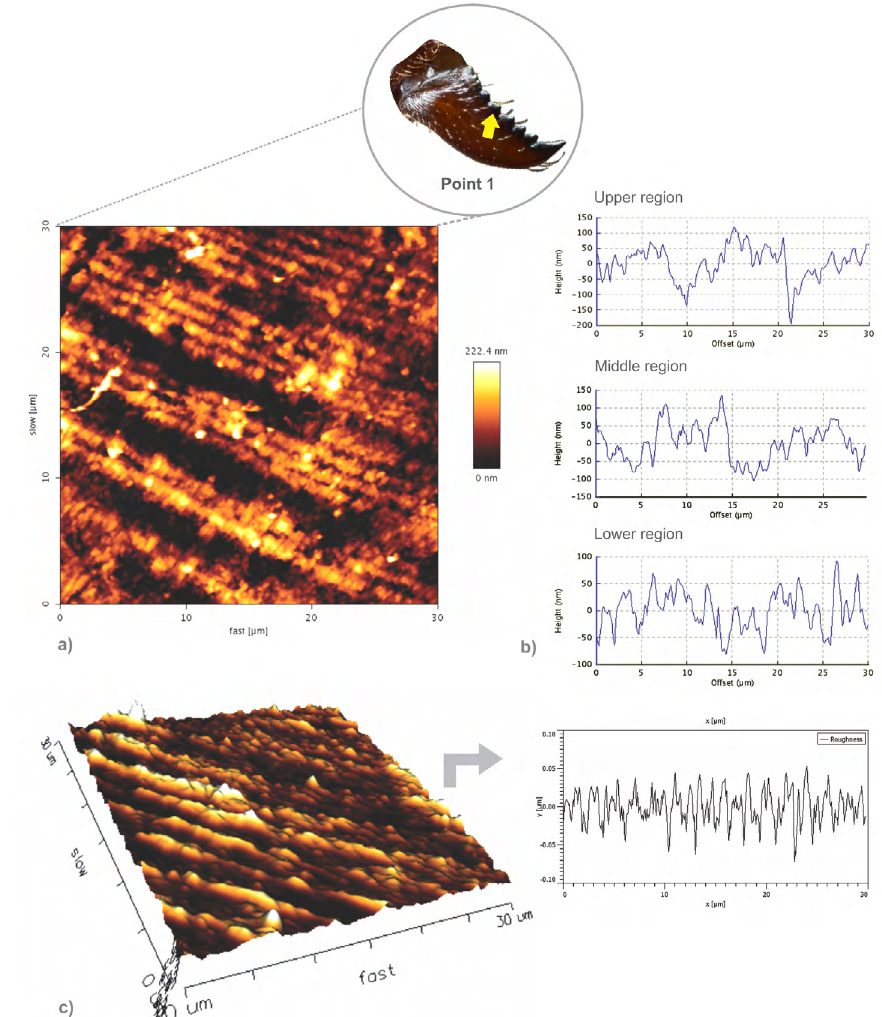
Figure 6. Topography of the internal region on the surface of the mandible of the ant Atta laevigata at different points, 30µm x 30µm: surface morphology (a), topographic profile in upper, middle and lower regions (b) and 3D topography